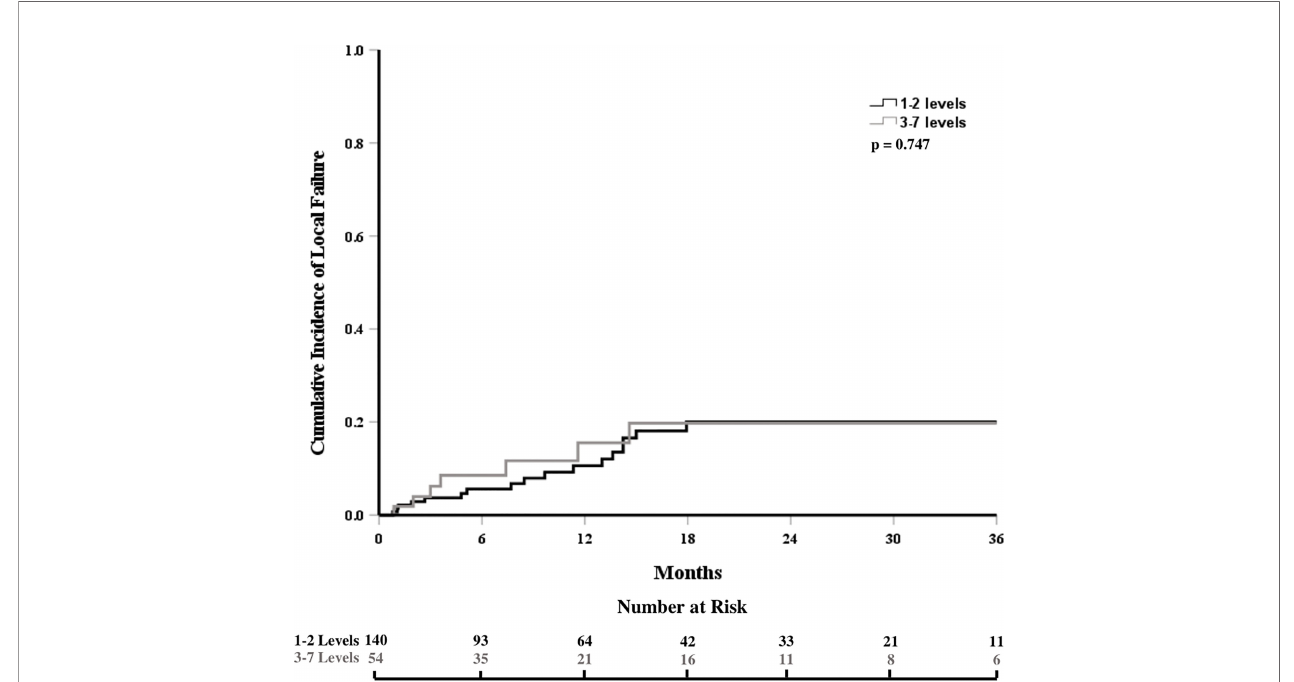
FIGURE 2 | Cumulative incidence of local failure strati fi ed by the number of contiguous treated levels.